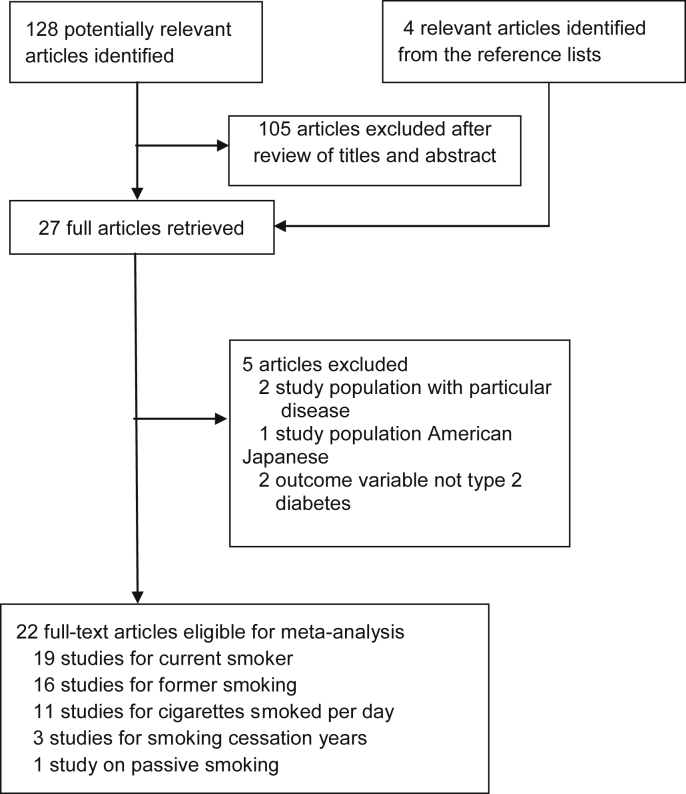
Flowchart of the selection of studies included in meta-analysis.